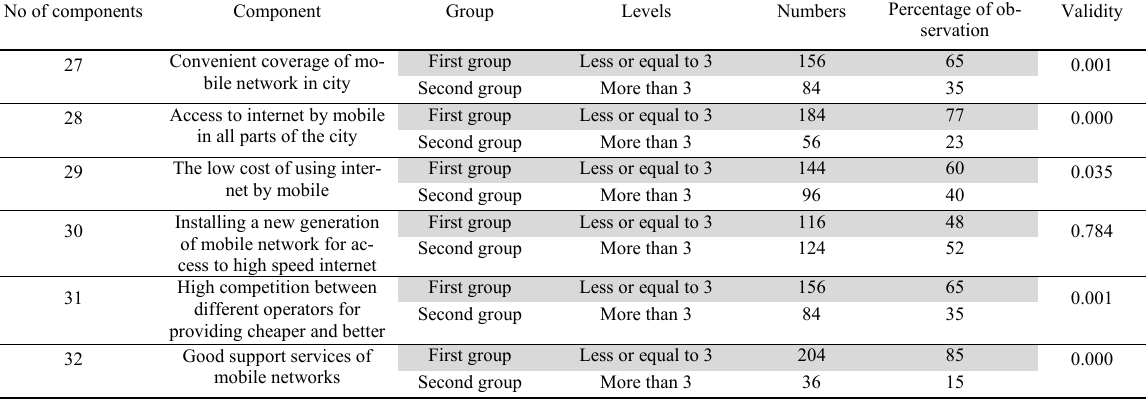
Statistical indicators for communication networks